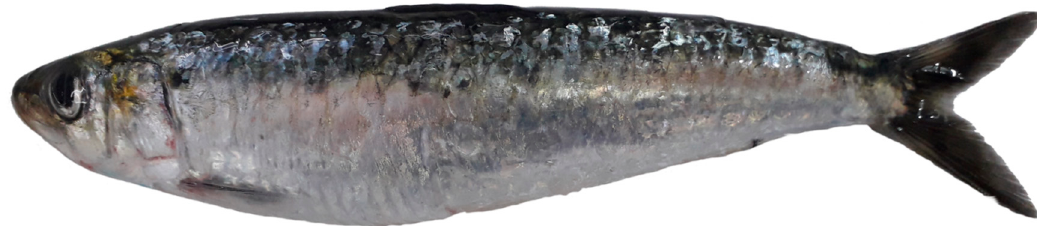
Figure 1. Photograph of a specimen of European sardine, Sardina pilchardus (photograph credits to Mónica Felício and André M.